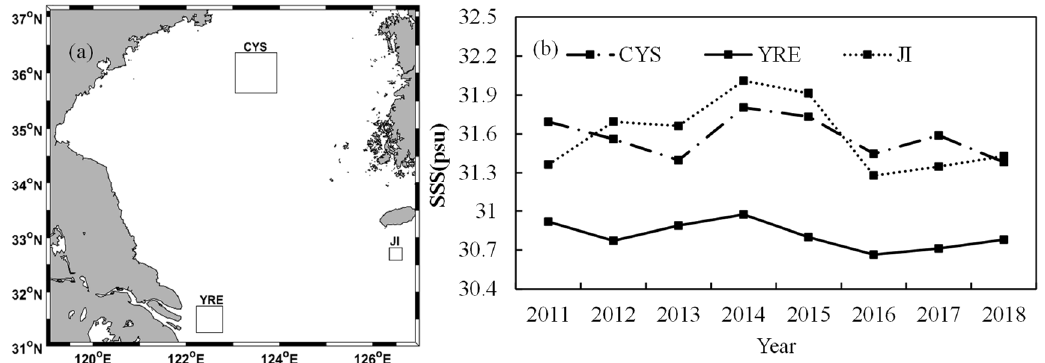
Figure 10. ( a ) Locations of three subareas of interest, including the central region of the SYS (CYS), the Yangtze River estuary (YRE), and the region near Jeju Island (JI); ( b ) Monthly mean time series of SSS for the three subareas.